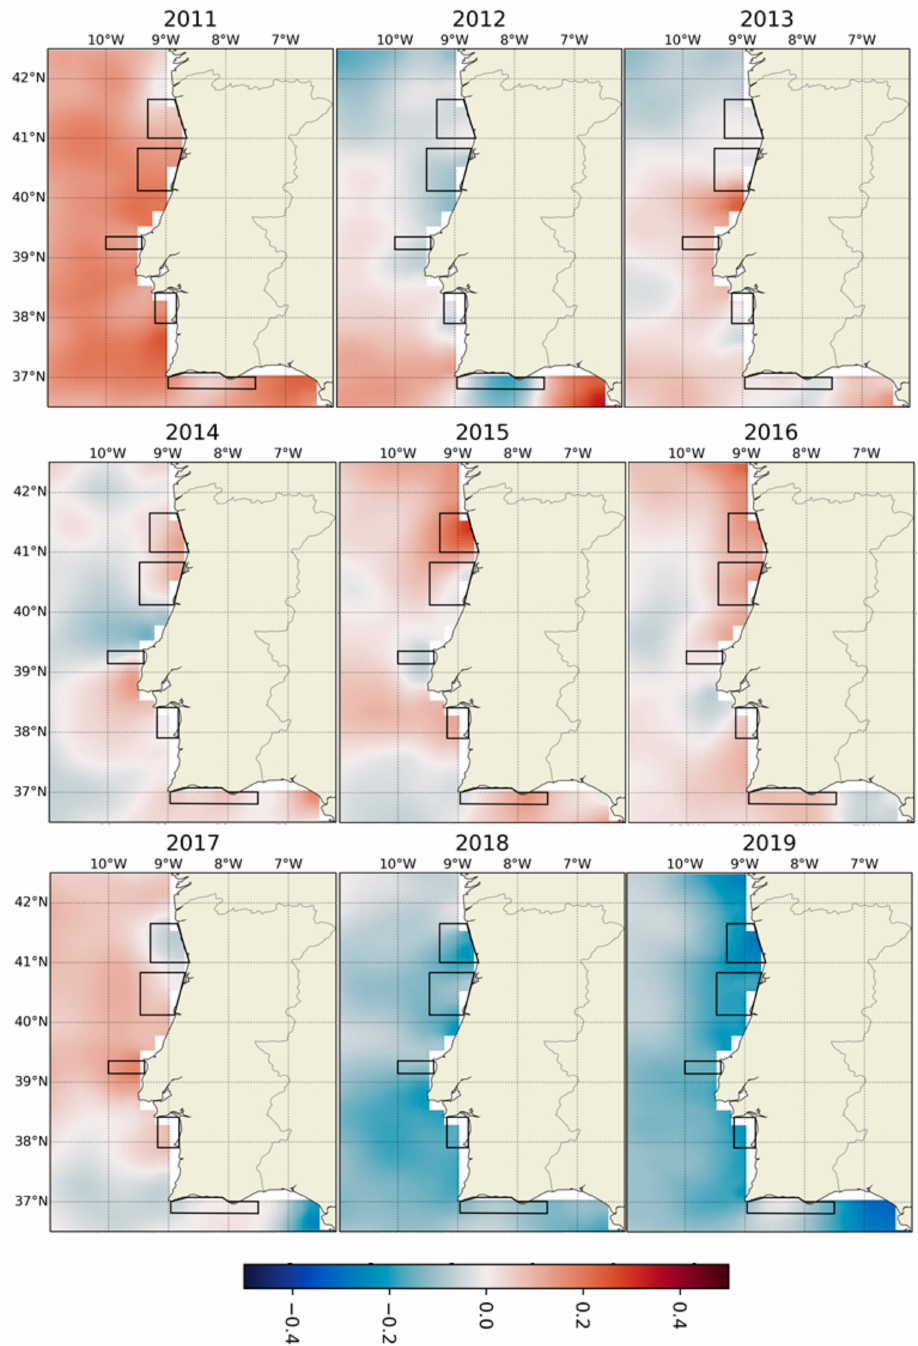
Figure 11. Sea surface salinity anomalies for each year between 2011 and 2019 using the satellite